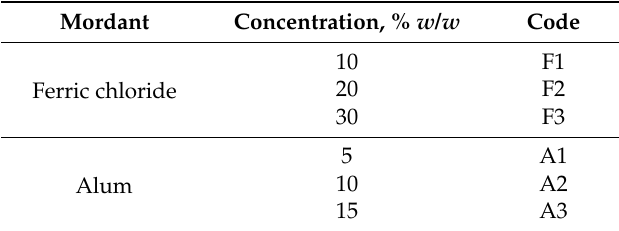
Table 1. Mordants studied for the pre-mordanting process and selected concentrations. Codes were assigned. Mordant Concentration, % w / w